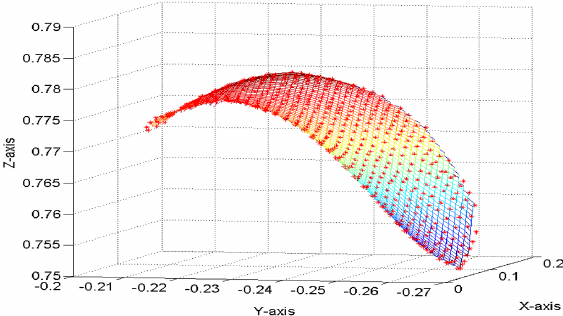
Figure 11. Fitting surface of leaf with double integral